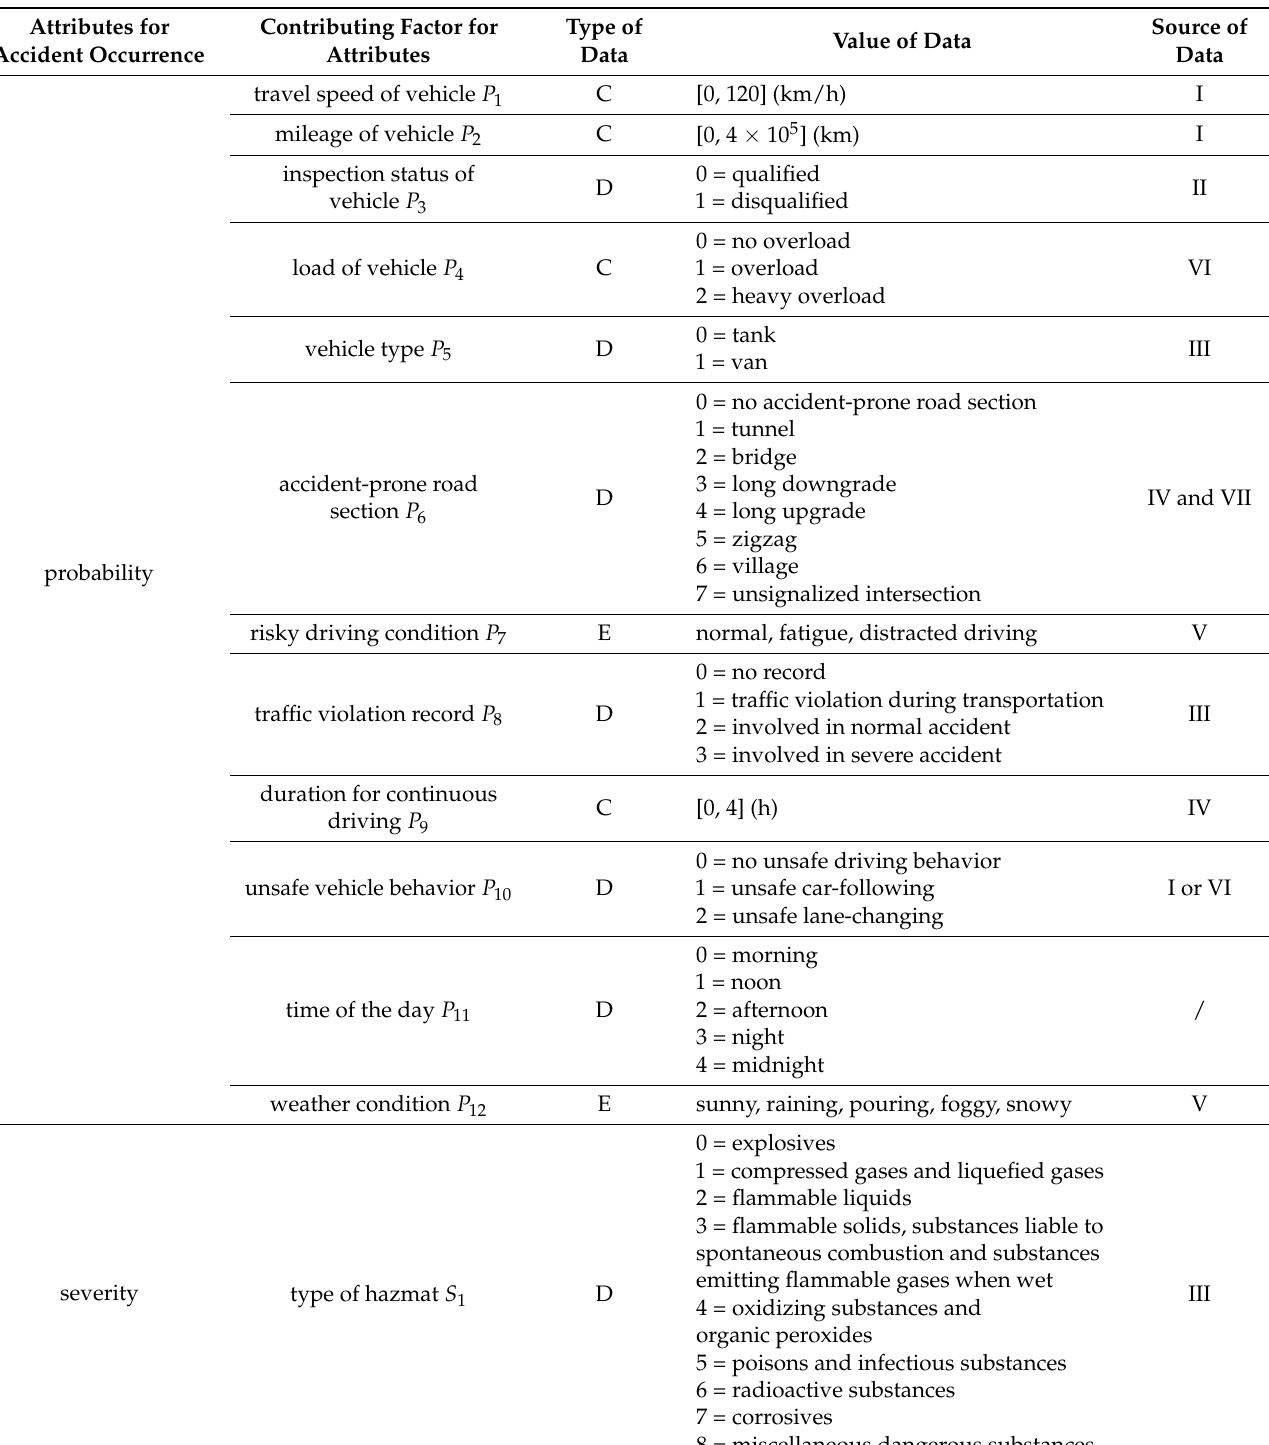
Table 2. Contributing factors for real-time risk of hazmat road